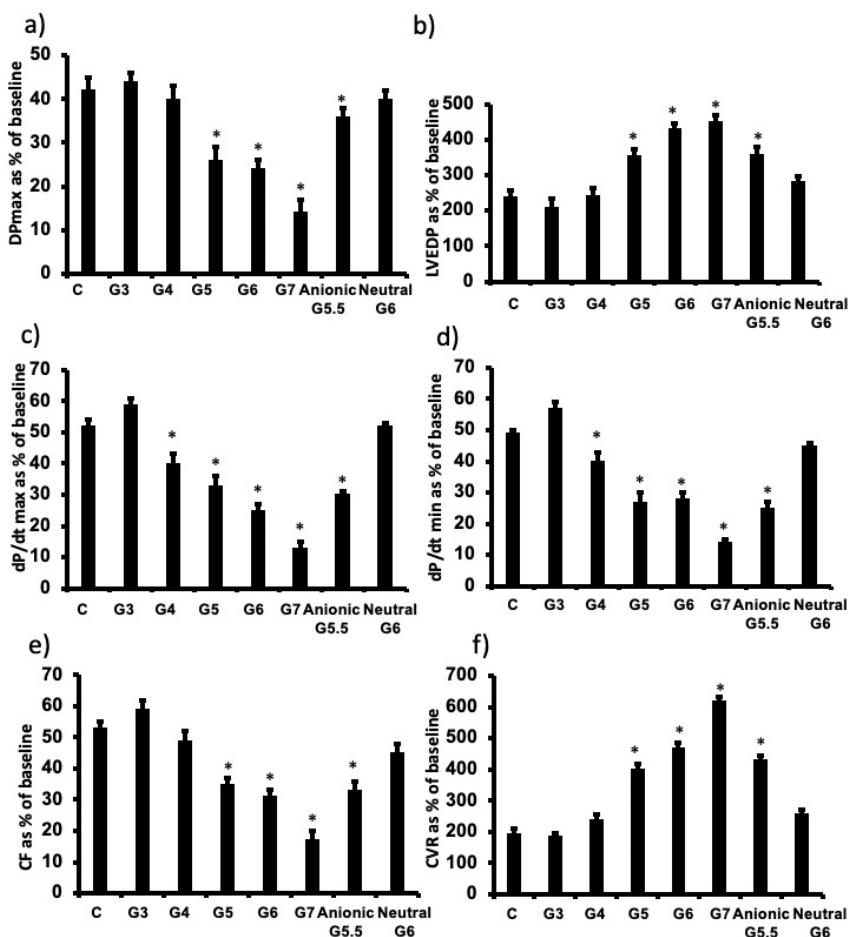
Figure 3. PAMAM-induced impairment in cardiac function is dependent on physicochemical prop- erties of molecular size (generation) and surface charge of PAMAM dendrimers. Post I/R recovery in the left ventricle function (DPmax ( a ) and LVEDP ( b )), contractility indices (+dP/dt ( c ) and –dP/dt ( d )) and coronary vascular dynamics (CF ( e ) and CVR ( f )) after treatment with various PAMAM dendrimer generations with variable molecular sizes (G3, G4, G5, G6, G7) or variable surface charge (cationic G6, anionic G5.5 or neutral G6). The data were computed after 30 min reperfusion and expressed as the mean ± SEM. DPmax: maximum developed pressure; LVEDP: left ventricular end-diastolic pressure; CF: coronary flow; CVR: coronary vascular resistance; G3: third generation PAMAM dendrimer; G4: fourth generation PAMAM; G5: fifth generation PAMAM; G6: sixth genera- tion PAMAM; G7: seventh generation PAMAM G4. Control hearts, C = I/R alone. N = 8. Asterix (*) indicates significant difference ( p < 0.05) from